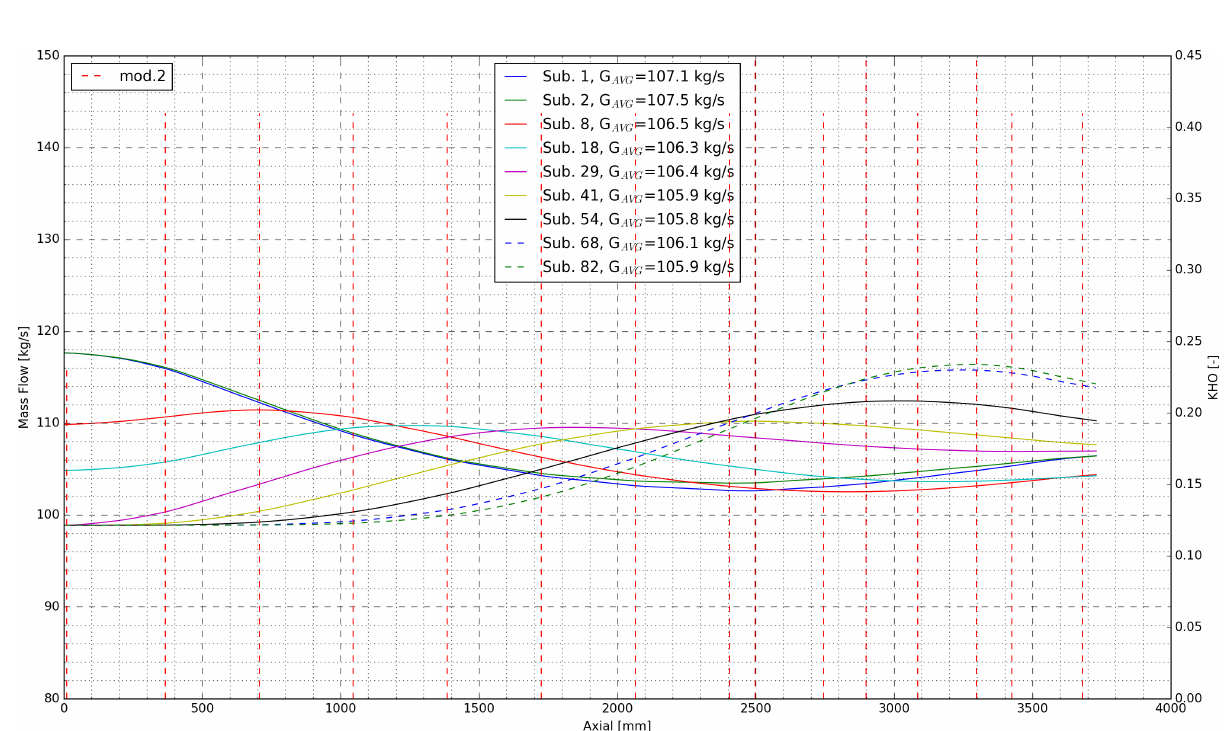
Figure 5. Mass Flow in homogeneous core - 163 TVSA-T mod.2.